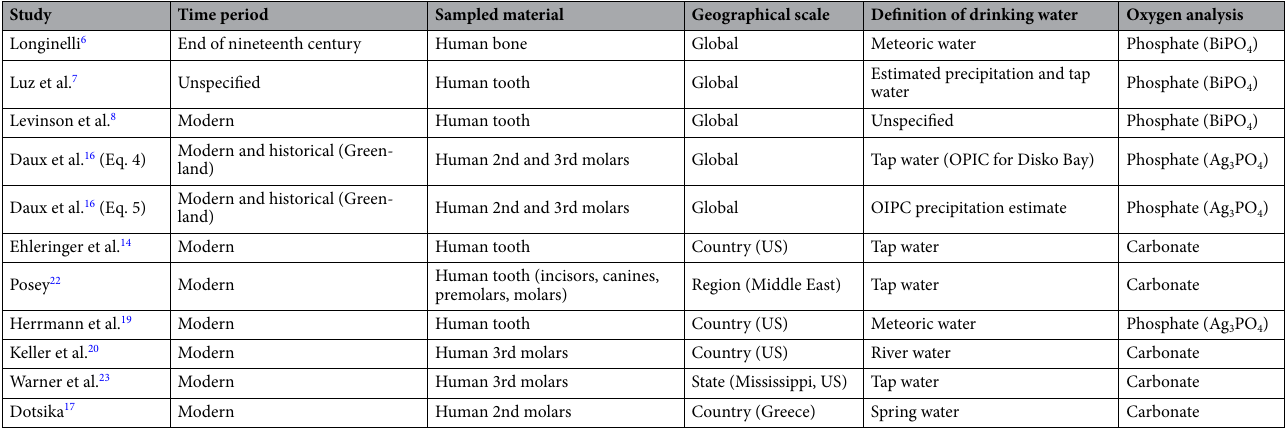
Table 1. Summary of studies on predictive